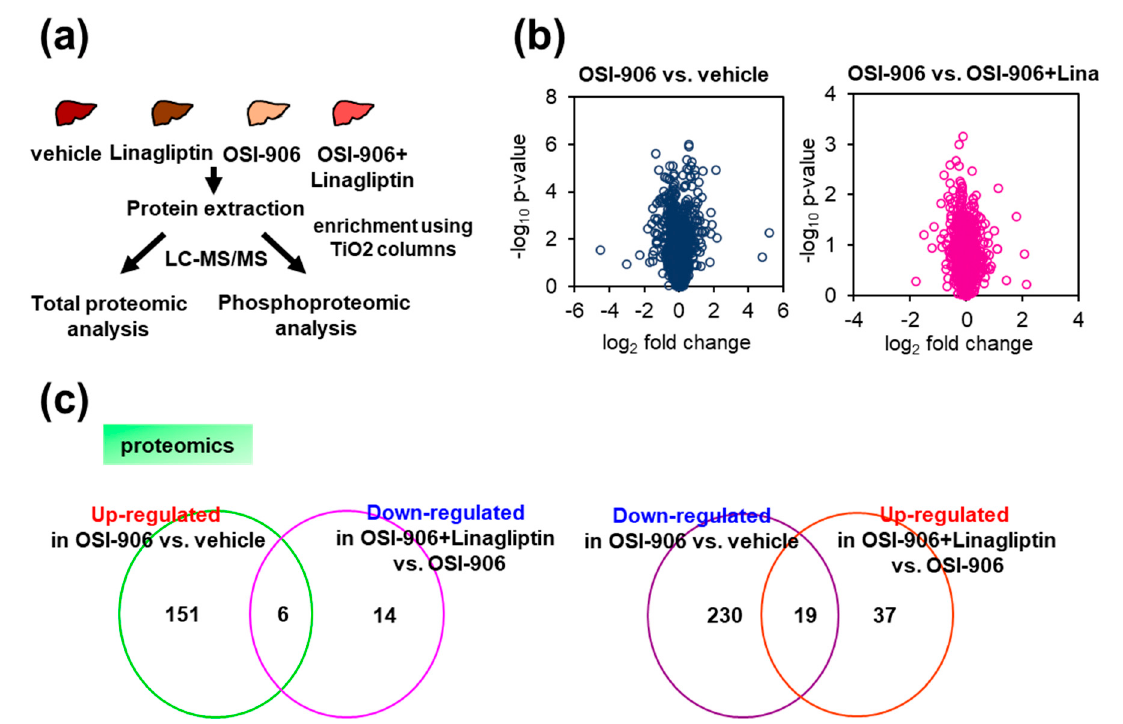
Figure 4. Proteomic and phosphoproteomic analysis of the liver from OSI-906- and linagliptin-treated mice. ( a ) Protocol for proteomic and phosphoproteomic analyses using liver samples ( n = 5 per group). ( b ) Volcano plot of hepatic proteomic data. Molecules identified in comparisons of vehicle vs. OSI-906 (left) and OSI-906 vs. OSI-906 + linagliptin (right) are shown ( n = 5 per group). ( c ) Venn diagram of differentially expressed molecules in OSI-906 vs. vehicle and OSI-906 + Lina vs. OSI-906 in proteomic analyses of liver samples. The numbers of proteins that were significantly upregulated or downregulated (ANOVA p -value < 0.05, fold change > 1.2) compared with the respective controls are shown ( n = 5 per group). The lists of overlapping proteins are shown in Supplementary Table S1.